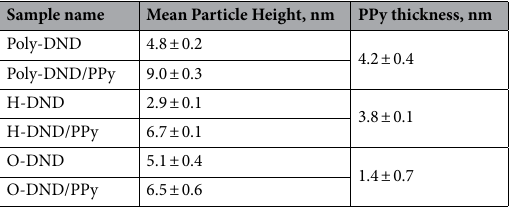
Table 1. Mean height of DND particles and the composites established from AFM topography data and calculated PPy thicknesses.